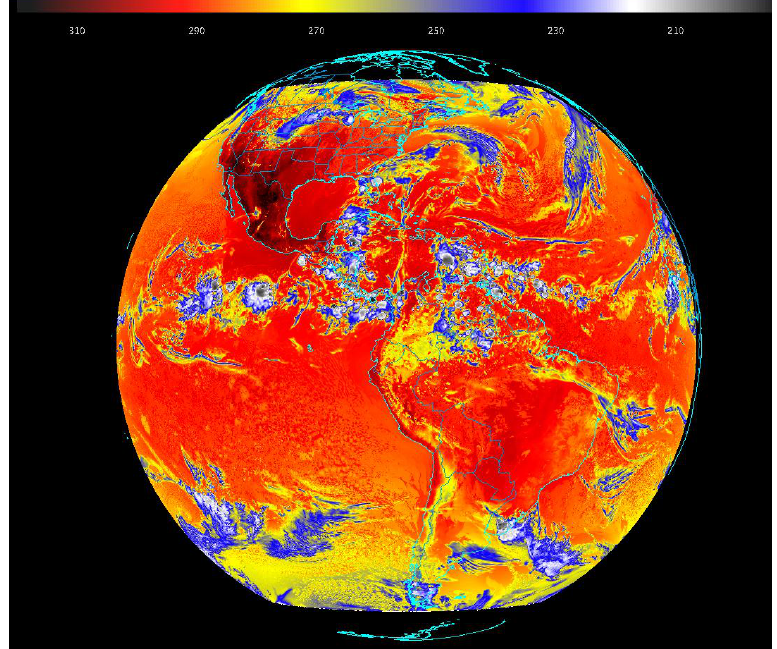
Figure 4. Brightness temperature (K) image corresponding to ABI Band 13 (10.1–10.6 µm) generated by the GS using simulated ABI data ( Courtesy: Cooperative Institute for Meteorological Satellite Studies